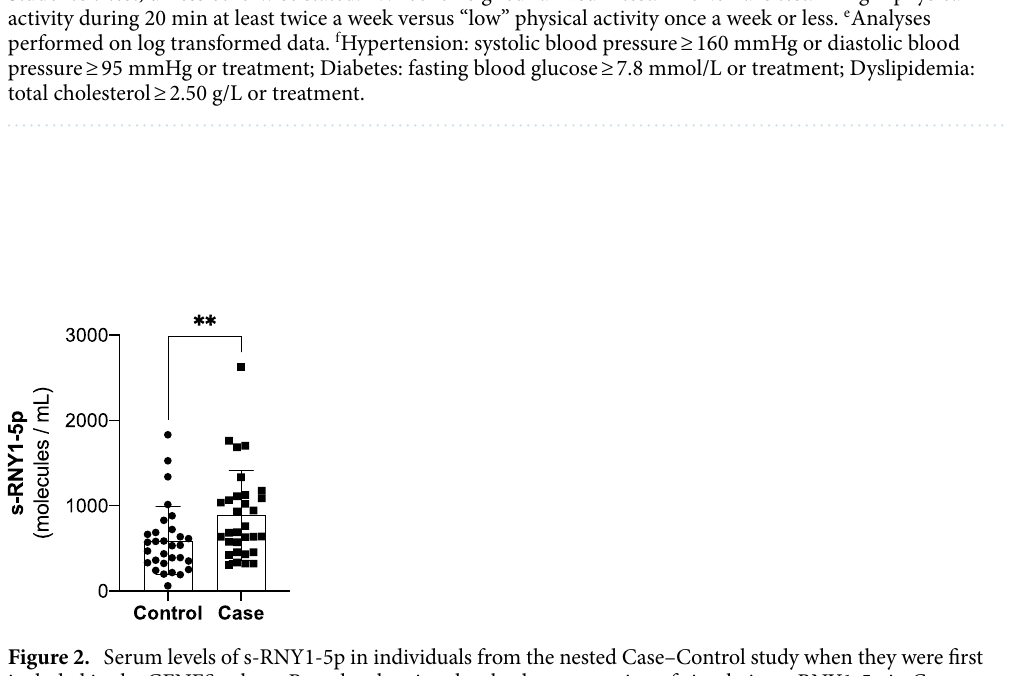
Table 1. Clinical and biological characteristics at baseline. Variables were measured at baseline (i.e. when individuals were first included in the GENES cohort). For continuous variables, values are expressed as mean ± SD. For categorical variables, values are expressed as number with frequency (%) in parentheses. BMI body mass index, hs-CRP high-sensitivity C-reactive protein, eGFR estimated glomerular filtration rate, γGT gamma glutamyl transferase, SBP systolic blood pressure, DBP diastolic blood pressure. a Paired